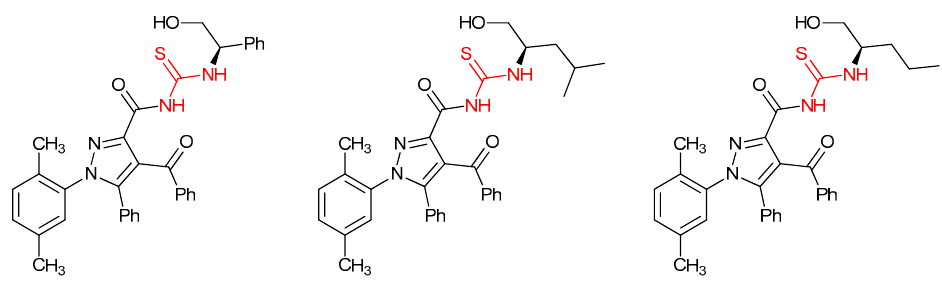
Figure 44. Novel chiral pyrazole-based thioureas exhibiting antibacterial activity [383].